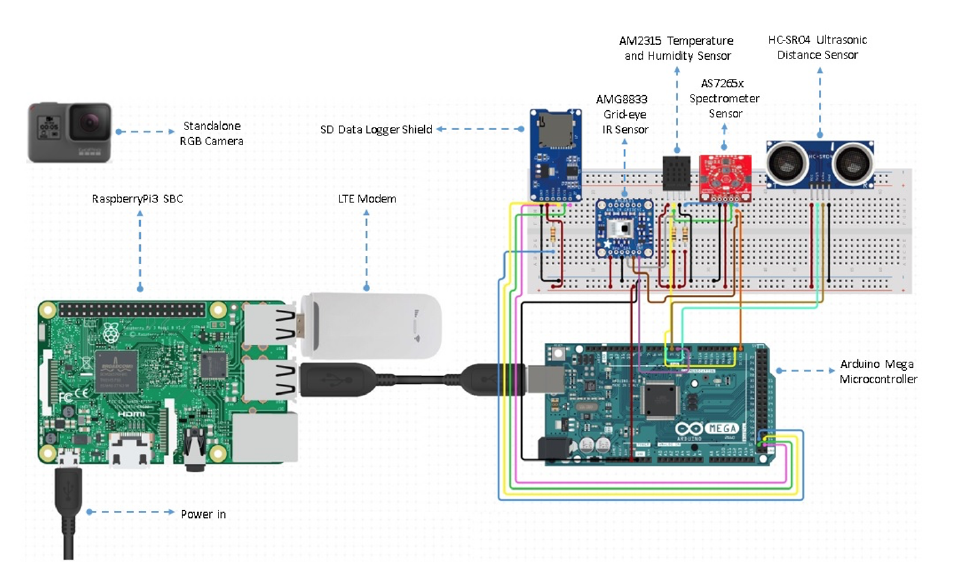
Figure 4. Aerial node